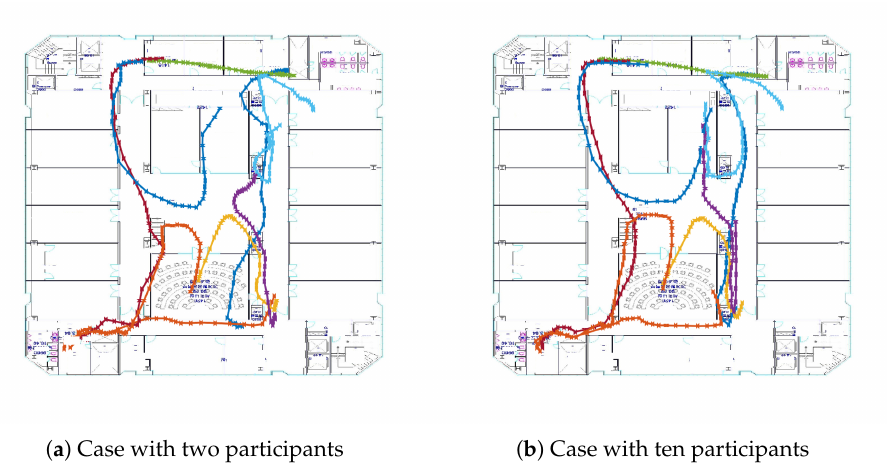
Figure 7. Experimental result of trajectory